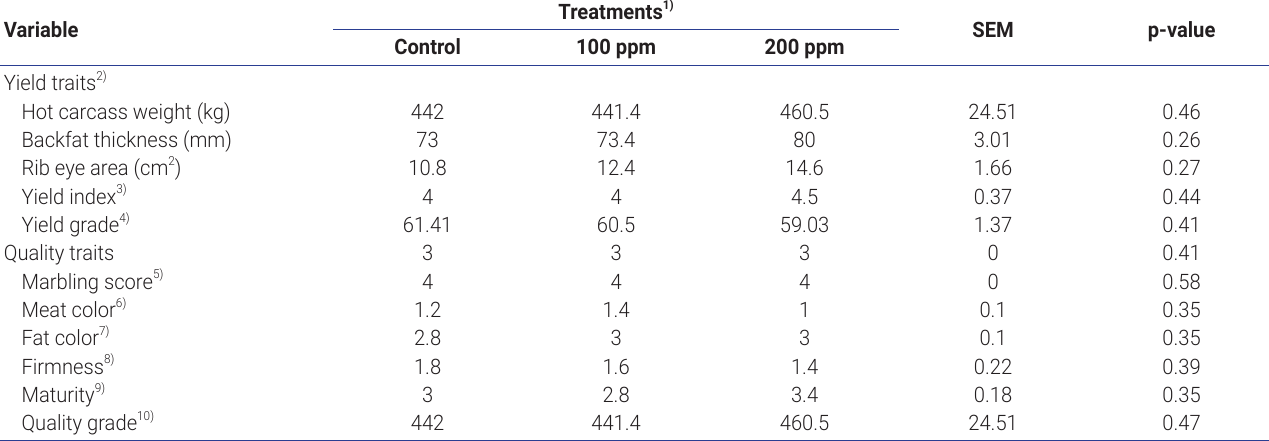
Table 2. Carcass traits of Hanwoo steers fed with rumen protected γ-aminobutyric acid